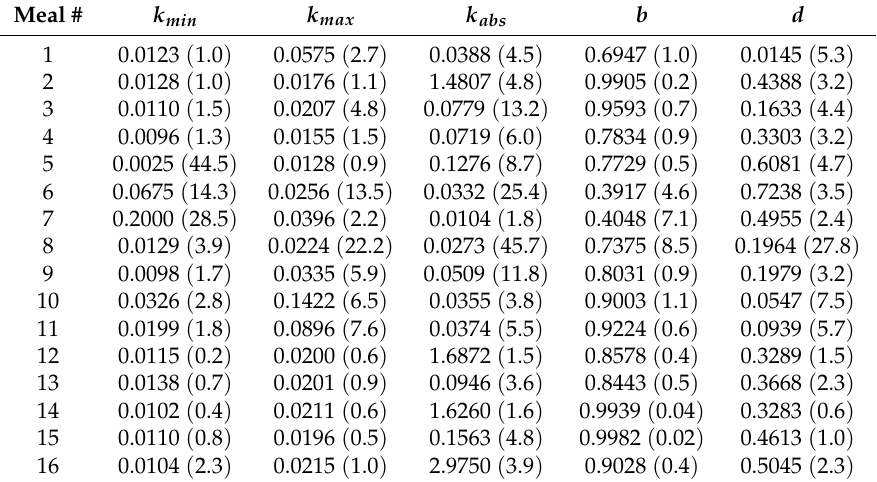
Table A2. Gastrointestinal model parameters corresponding to the 16 selected mixed meals. Coefficient of variation (%) provided by the Matlab lsqnonlin optimization routine is reported in brackets.